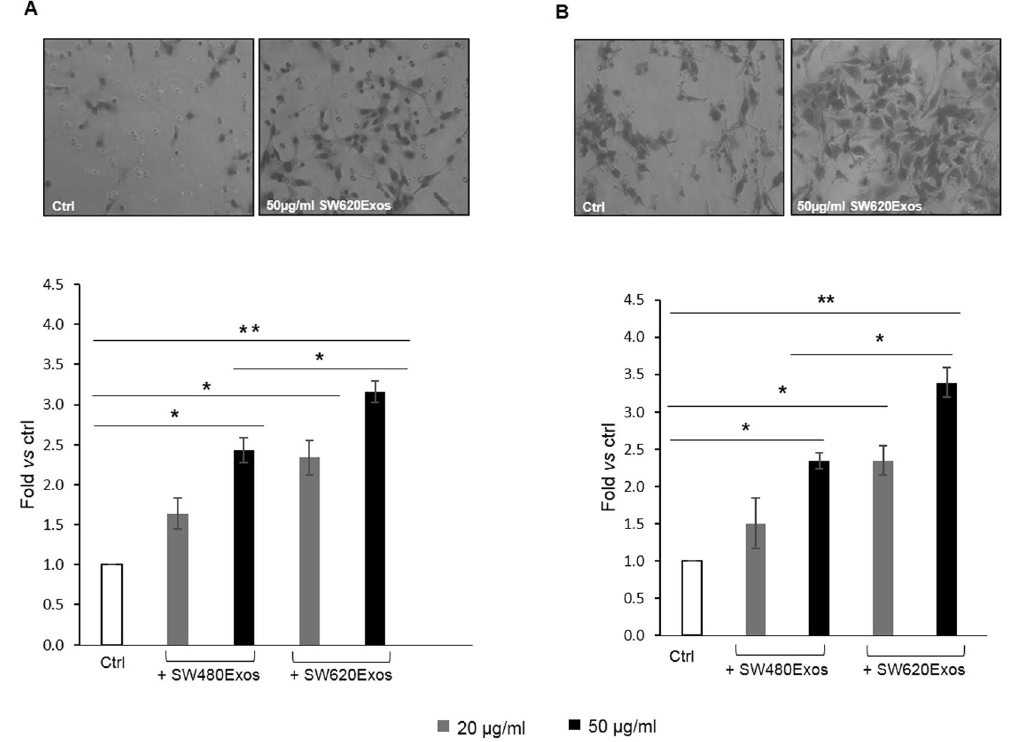
Figure 3. Exosomes released by metastatic cells enhance motile and invasive properties of less aggressive tumor cells. Transwell migration ( A ) and invasion ( B ) assay of SW480 cells treated with increasing doses (20 or 50 µ g/ml) of SW480Exos or SW620Exos. Representative micrographs (upper panel) and quantitative data (lower panel) are reported for each assay. Ctrl (Control): SW480 cells without exosome treatment. Values reported in the graphs are the mean ± SD of 5 fields in three independent experiments. Statistical significance was calculated vs ctrl and between the same doses of SW480Exos and SW620Exos as indicated by the horizontal lines; * p ≤ 0.05, ** p ≤